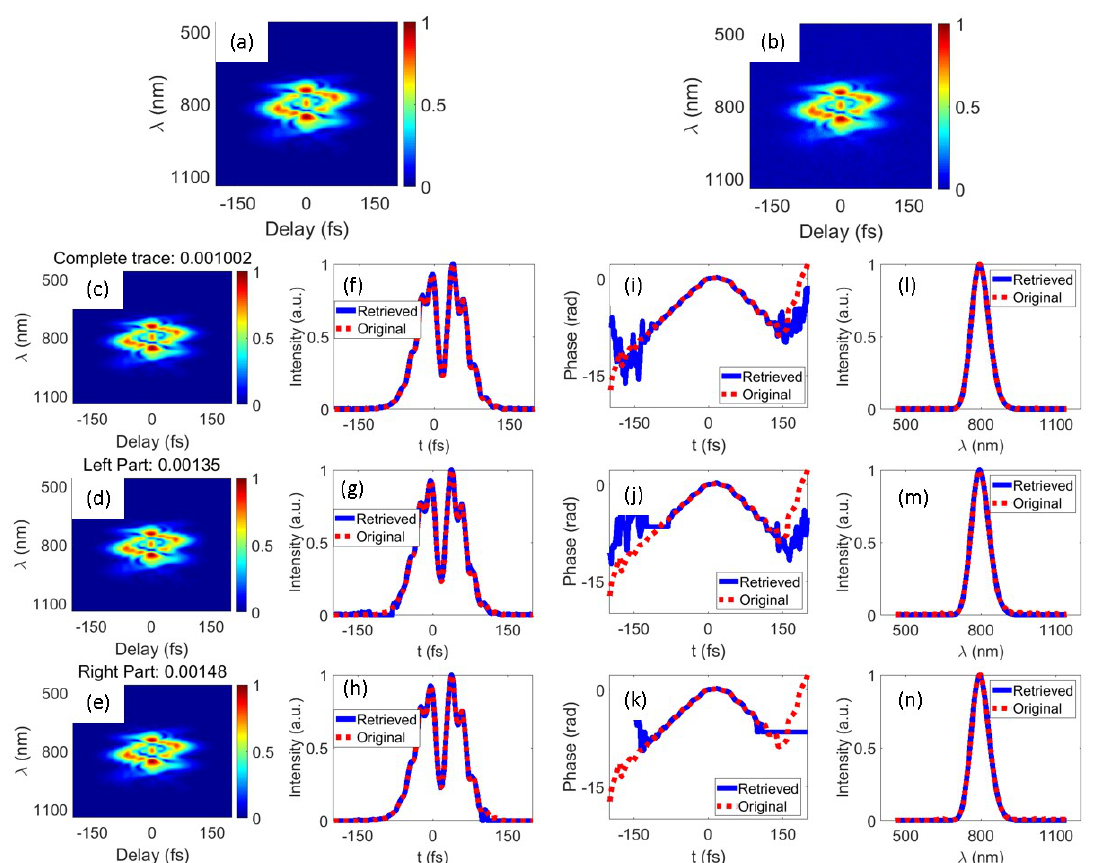
Figure 2. Numerical reconstruction from an unpolluted THG − FROG trace. ( a ) Simulated FROG trace of measured pulse ( b ) noised trace of the measured pulse, ( c – e ) reconstructed traces, ( f – h ) amplitude of reconstructed pulses, ( i – k ) phase of reconstructed pulses, and ( l – n ) spectral intensity distributions of the reconstructed